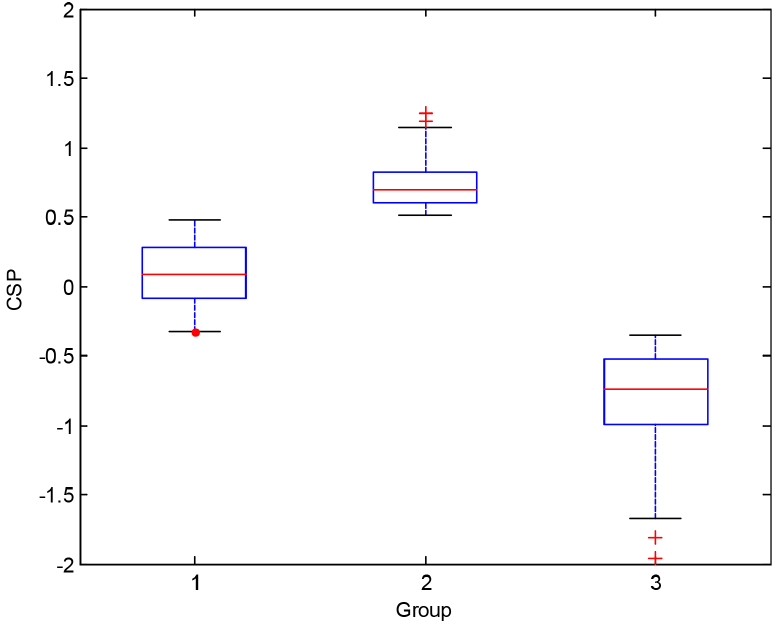
Fig. 2. Boxplot of CSP by